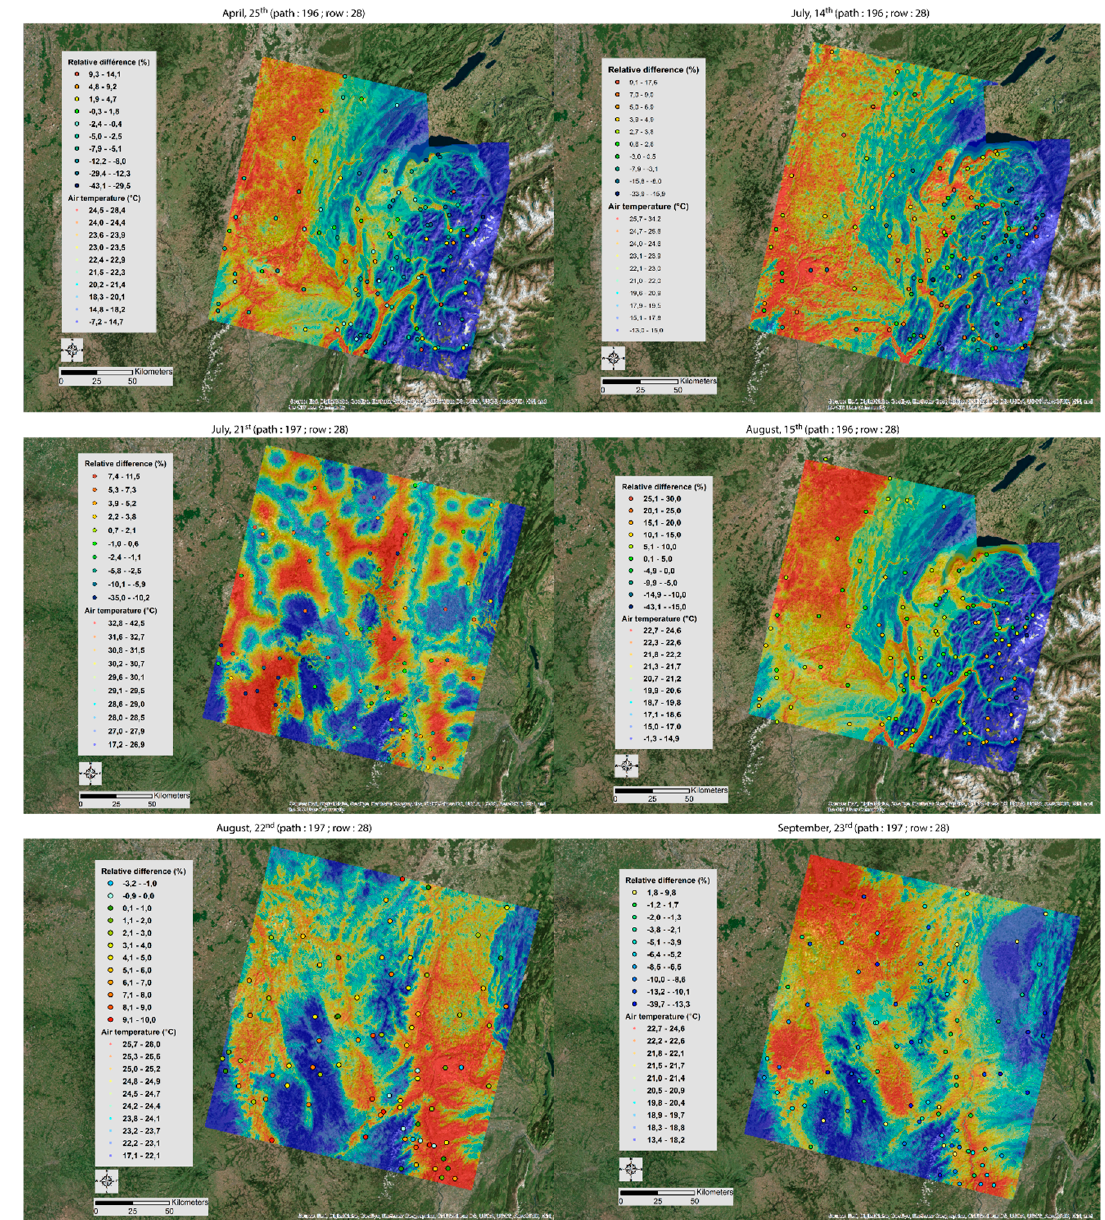
Figure 2. Estimated air temperature for all days studied with relative difference between the modelling and the in situ measurements (quantile discretization).